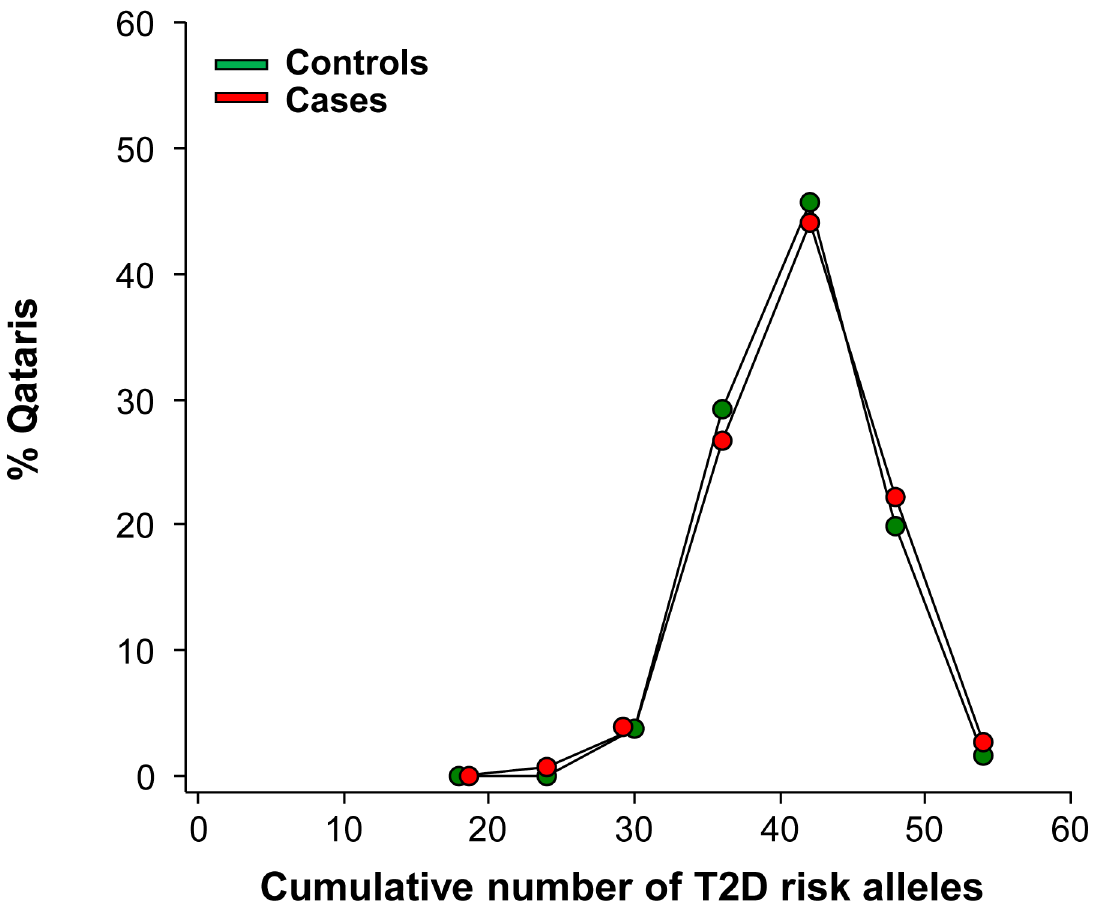
Fig 3. Cumulative distribution of 37 Type 2 Diabetes (T2D) risk allele counts. Cumulative distribution of 37 T2D risk allele counts in Qataris (n = 952) cases (red, n = 626), and controls (green, n = 326). Two-tailed, unequal variance t-test, p = 0.26.